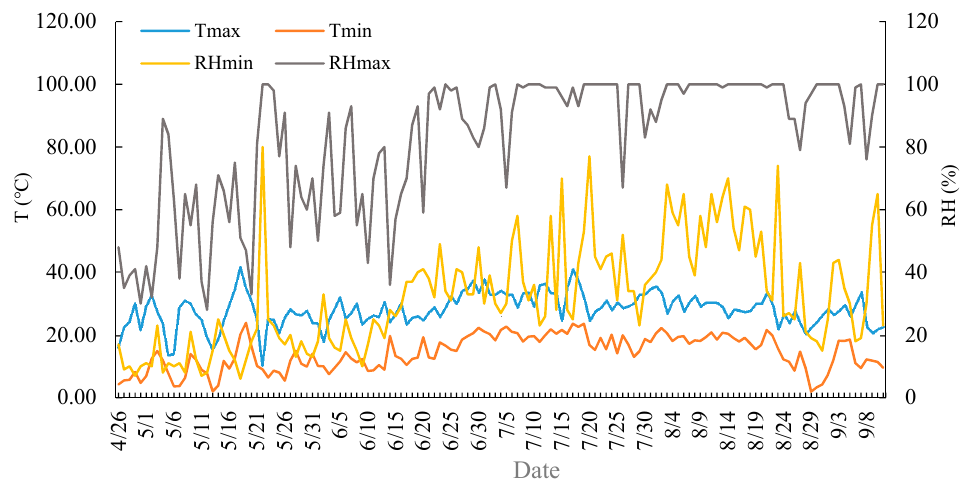
Figure 3. Variation of the temperature and relative humidity of the experimental site during the growth period of maize. Note: T max represents the maximum of temperature; T min represents the minimum of temperature; RH max represents the maximum of relative humidity; RH min represents the minimum of relative humidity.